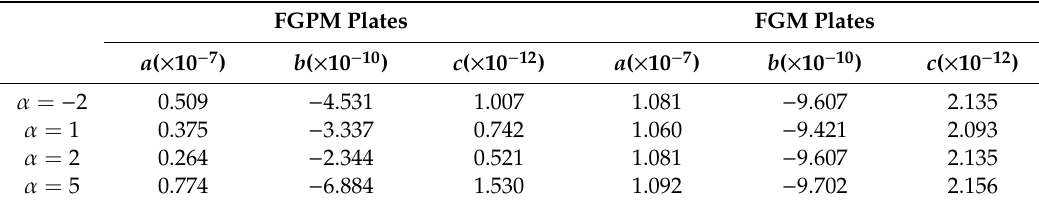
Table 5. Coe ffi cients of deflection for FGPM plates and FGM plates. Table 5. Coefficients of deflection for FGPM plates and FGM plates.